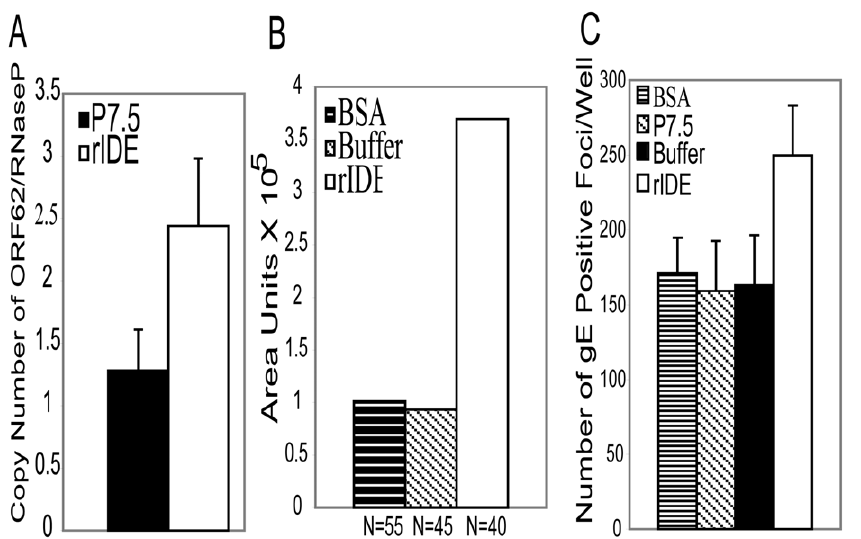
Figure 4. rIDE promotes VZV internalization during entry and cell-to-cell spread of virus. (A) Cell free ROka-lacZ was incubated with P7.5 control protein or rIDE for 30 min at 37 u C, the mixture was incubated with cells for 60 min on ice to allow binding followed by 90 min at 37 u C for entry, and DNA was then extracted from the cells and the copy number of intracellular VZV genomes was determined by real-time PCR. The ratio of VZV ORF 62 DNA to cellular RNaseP DNA is shown on the y axis. The experiment was performed three times and a representative result is shown. (B) Melanoma cells were infected with ROka-lacZ, 2.5 hrs later the inoculum was removed by washing with PBS, rIDE was added to the cells, and 3 days later the cells were stained with X-gal. Blue VZV-infected foci were photographed at a magnification 40X and plaque sizes were measured with ImageJ software as previously described [3]. N is the number of plaques measured. (C) Cell-free VZV from a commercial lot of zoster vaccine was incubated with rIDE for 30 min, melanoma cells were infected with the mixture for 4 days, and the cells were fixed and stained with anti-gE monoclonal antibody and infected foci were visualized by fluorescence microscopy. The graph represents pooled data from three independent experiments. Vertical lines indicate standard deviations.